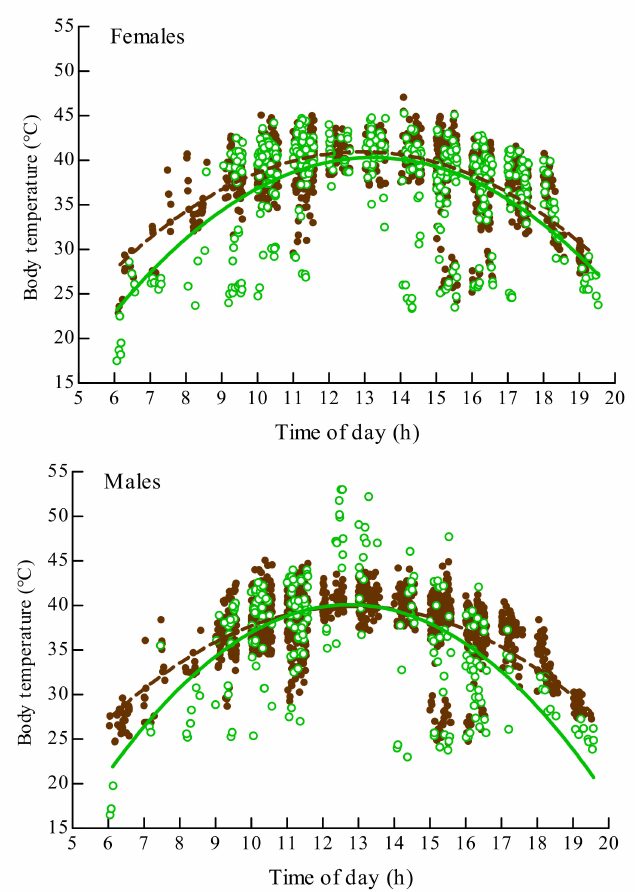
Figure 4. The ‘time-course’ of internal body temperature changes for females and males of Oedaleus decorus asiaticus from eight different regions. The green morphs are shown with open symbols; coloured lines show smoothed trends for brown (dashed lines) and green morphs (solid lines).